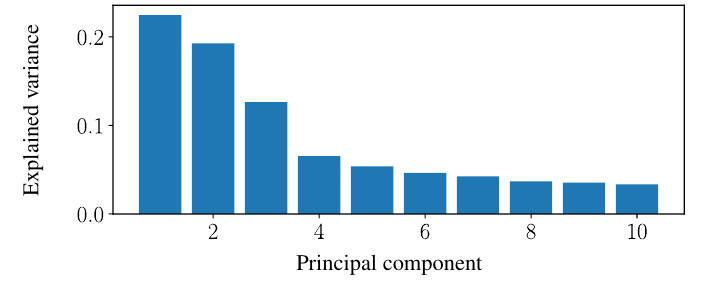
Figure 1: Proportions of variance explained by each principal component.